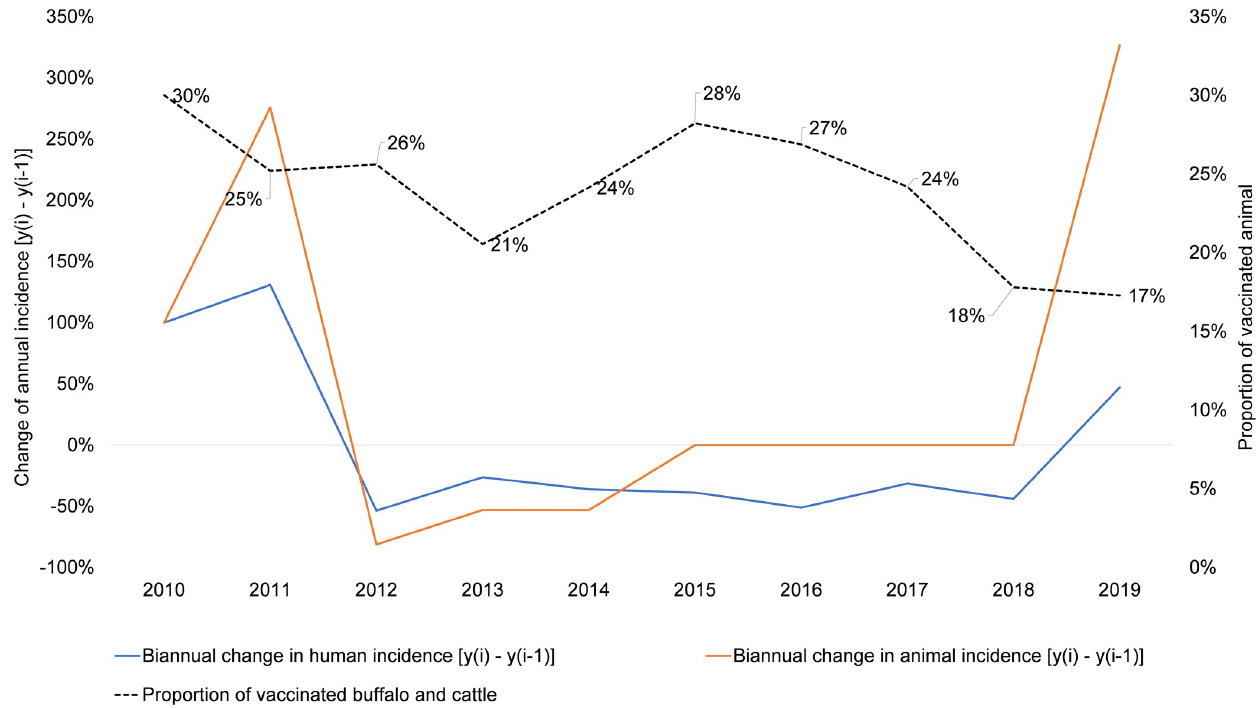
Fig 7. Association between vaccination coverage in livestock and biannual change in incidence of human and livestock anthrax (2010–2019), Dien Bien province, Vietnam.